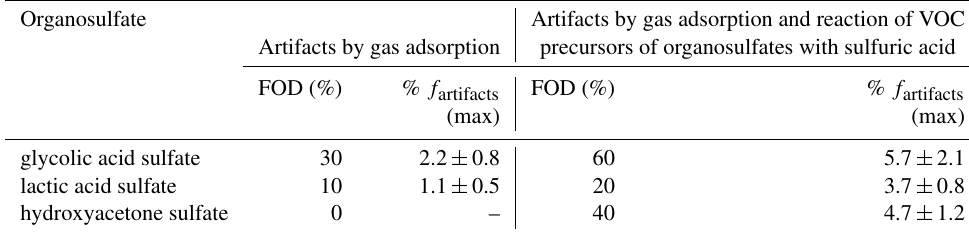
Table 3. Positive filter sampling artifacts associated with the three most abundant organosulfates quantified in Centreville, AL, from 7 to 11 July 2013 due to gas adsorption alone and gas adsorption and reaction of VOC precursors of organosulfates with sulfuric acid. Given in the table are frequency of detection (FOD, n = 10) and positive filter sampling artifacts as a fraction of their PM 2 . 5 concentrations (% f